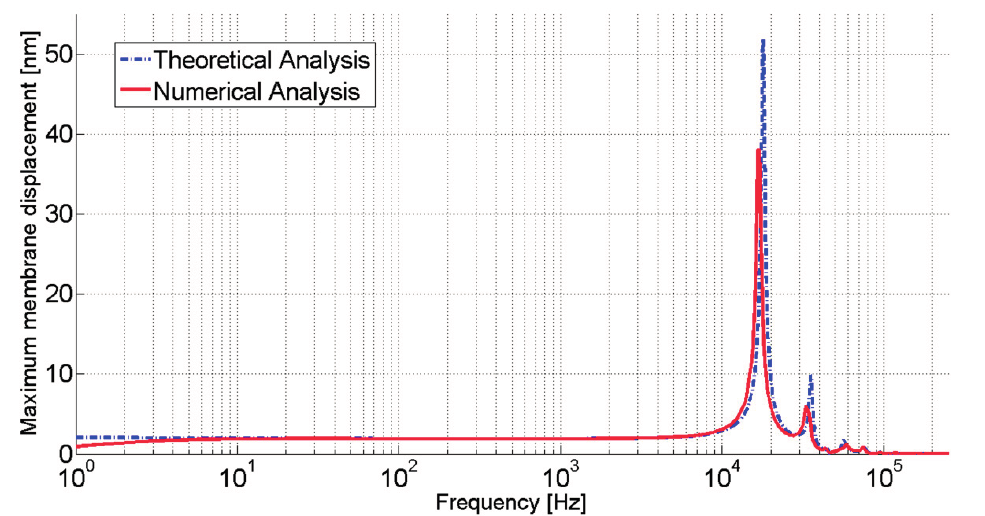
Figure 5. Comparison of the membrane displacement of theoretical and numerical analysis of the acoustic transducer (for (cid:1844) = 500 N/m and (cid:1872) (cid:1846) (cid:3040)